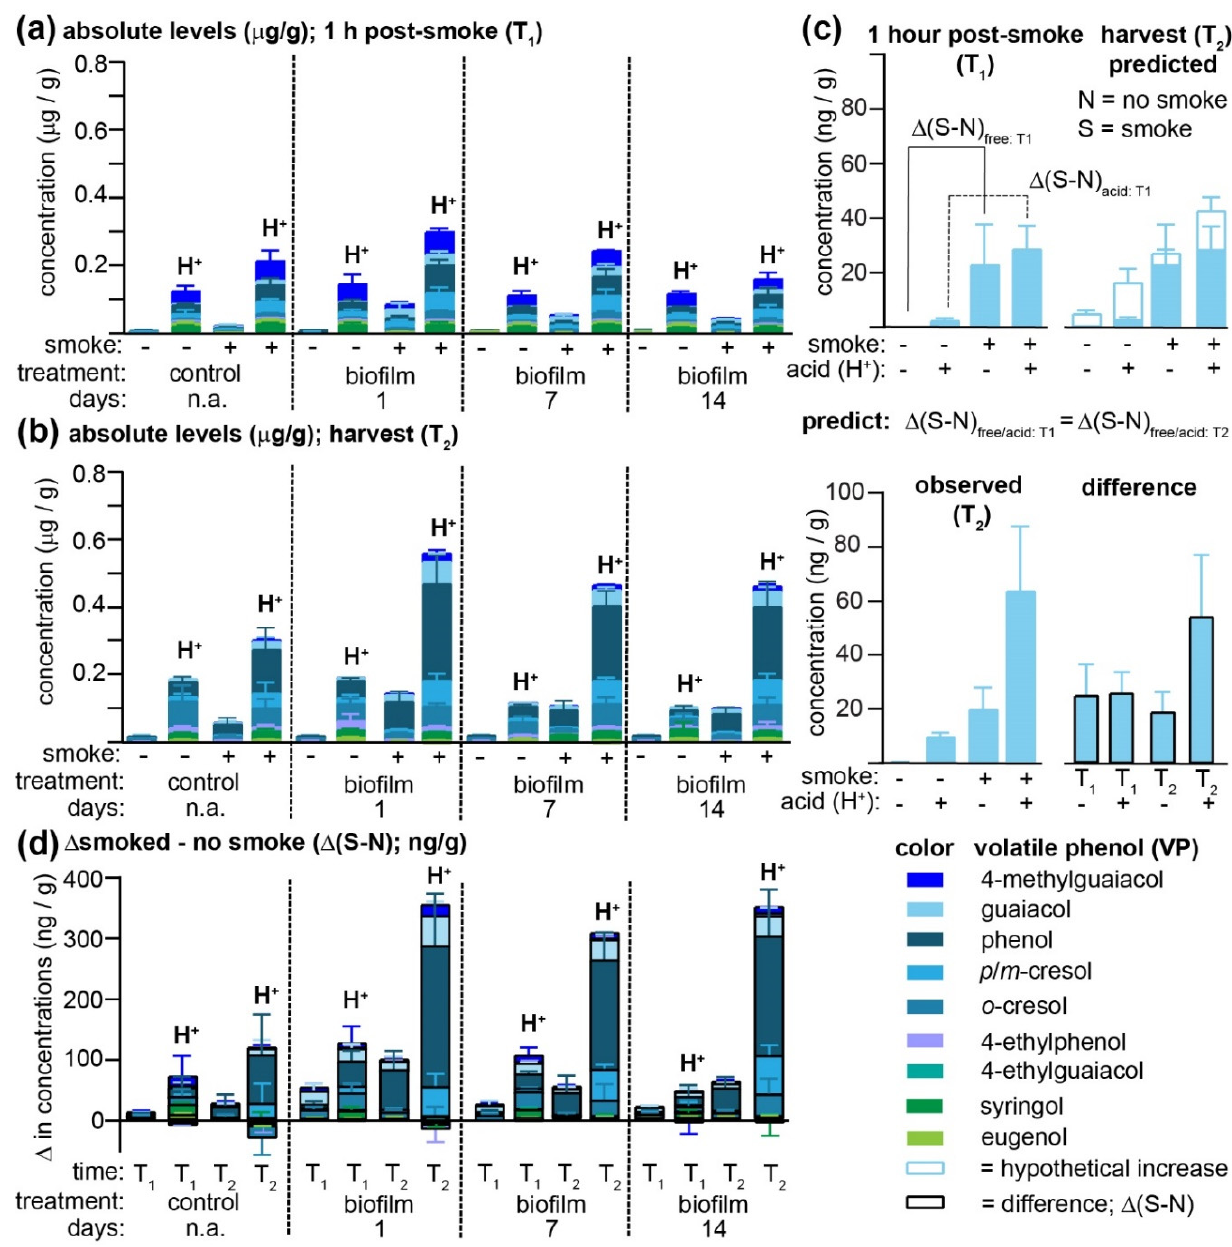
Figure 2. Re-evaluation of the capacity for and duration of smoke-taint protection afforded by the biofilm spray when applied one, seven or 14 days before smoke exposure at a single vineyard (vineyard 1), as compared to a spray-free control. Both free and acid-labile (H + ) VPs were quantitated by GC–MS/MS ( a ) immediately (i.e., within 1 h; T 1 ) following smoke exposure, and ( b ) at commercial maturity (T 2 ). ( c ) It was hypothesized that the difference ( Δ ) in VP levels between grapes that had been smoke exposed (S), and non-exposed (N) controls would be equivalent at T1 and T2—as illustrated here using guaiacol concentrations in the grapes treated with biofilm 1 day prior to smoke exposure (top panel)—since all grapes were otherwise subjected to identical growing conditions until harvest. The actual Δ (S-N) for samples at harvest (black outline; lower panel), however, indicates a rise in acid-labile VP conjugates. ( d ) Acid-labile conjugates of smoke-derived phenol, p / m -cresol, guaiacol, and 4-methylguaiacol all increased as berries ripened. All error bars represent the SEM of n = 4 replicates except in ( d ), where they denote the quadrature-sum of the SEM.